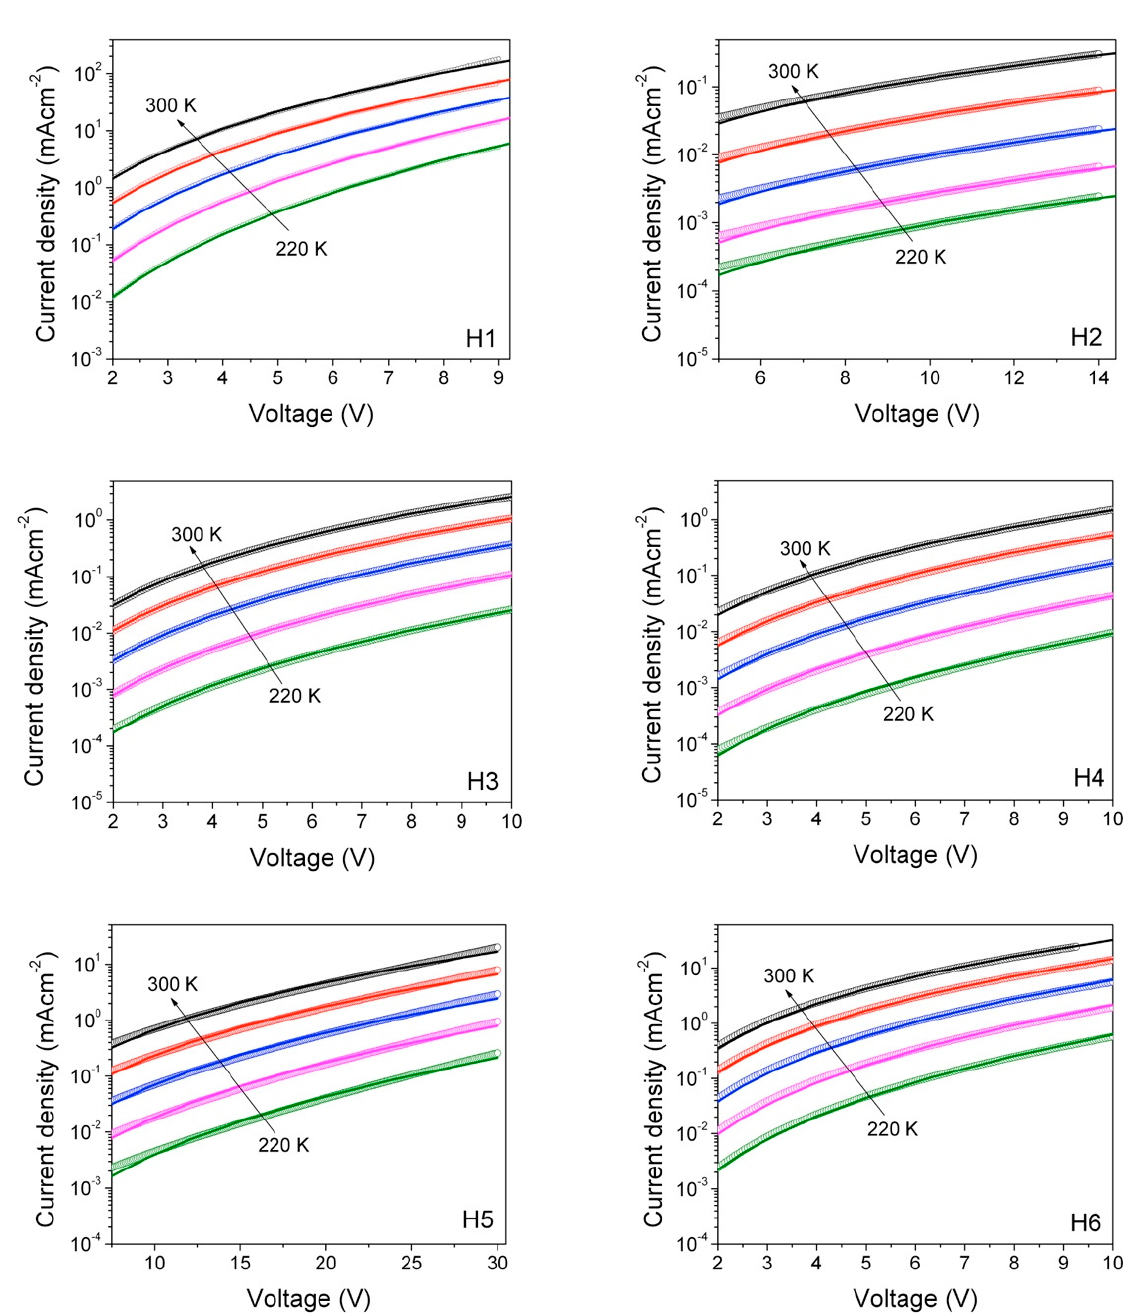
Figure 10. Temperature dependent density current–voltage characteristics of hole-only devices based on the six materials investigated (open circles). The fits to the experimental data (solid lines) are also reported, according to the Murgatroyd-Gill equation.